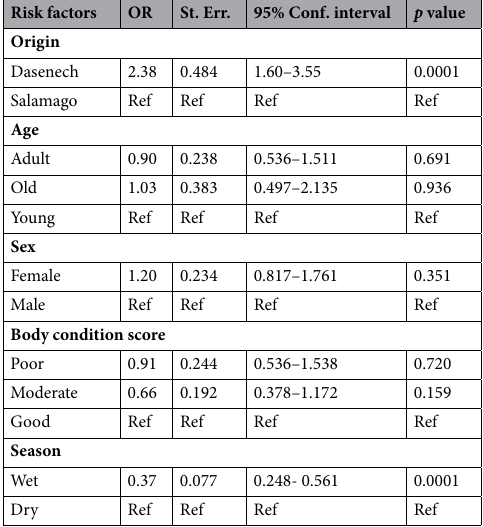
Table 5. Multivariate logistic regression of host factors and prevalence of ixodid tick.